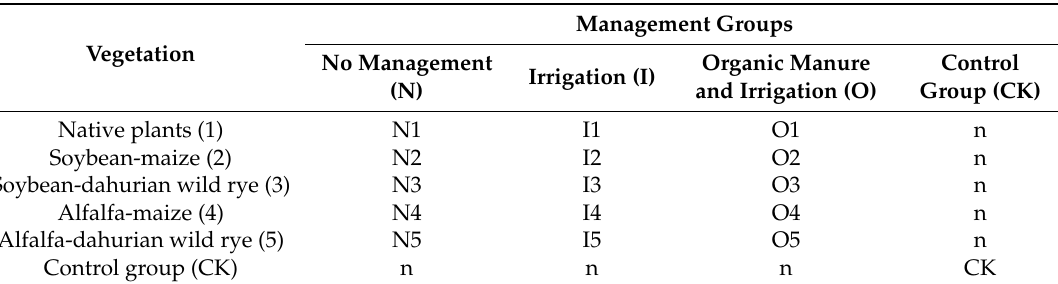
Table 1. Treatments applied for